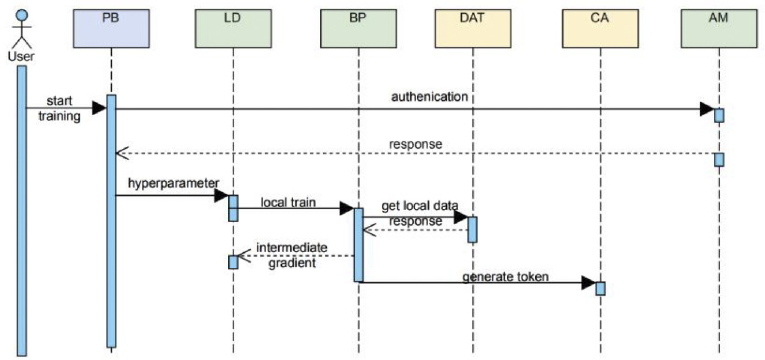
Figure 3. Time sequence of gradient generation